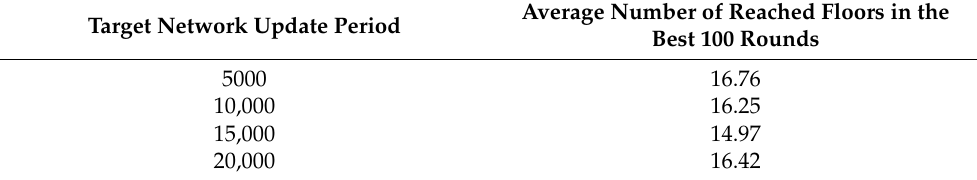
Table 14. Average number of reached floors in the best 100 rounds for different target network update period.